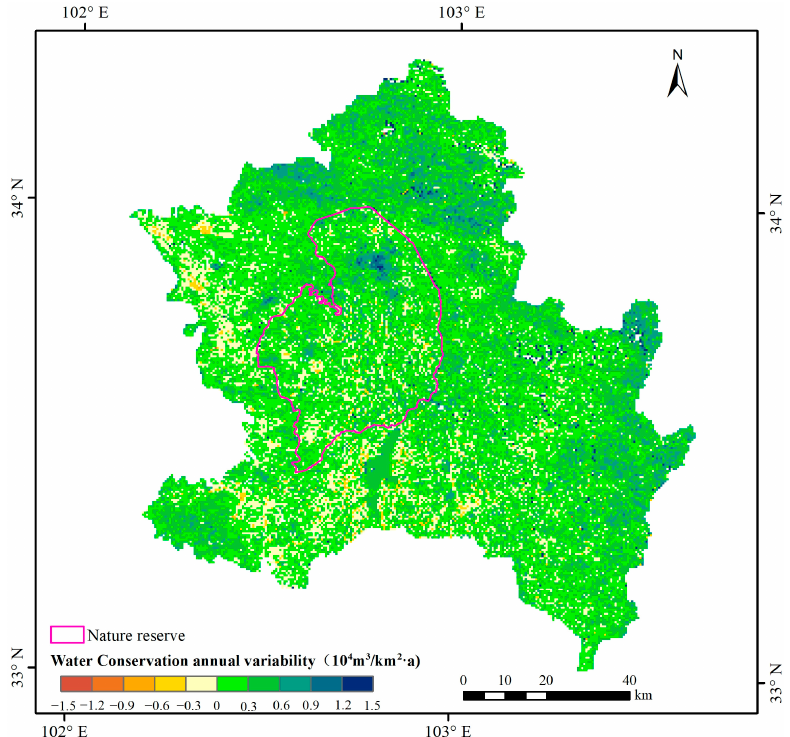
Figure 10. Variation trend in water conservation of Zoige county from 2001 to 2020.